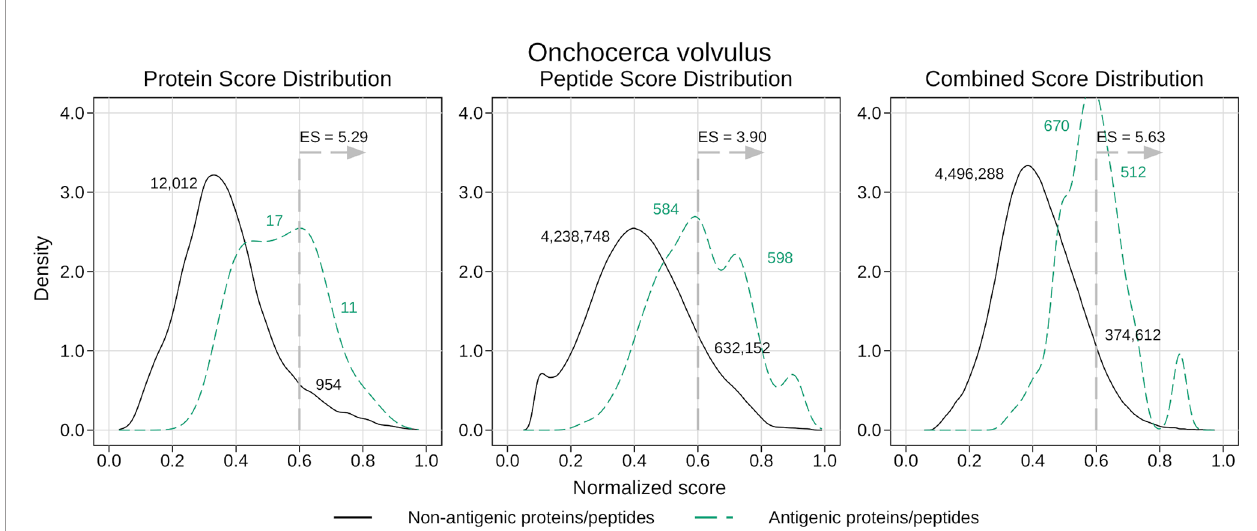
FIGURE 5 | Density analysis for the antigenicity scores of Onchocerca volvulus . Plots were obtained by analyzing the proteome of O. volvulus with the fi nal generic models, and then distinguishing between antigens and non-antigens. The fi gure shows the enrichment score obtained by keeping only the proteins and peptides with a score greater than 0.6, as well as the amount of antigens and non-antigens that would be inside or outside that subset. The plots correspond to the case where a protein was tagged as antigenic if it had at least 3 ‘ immunoreactive ’ peptides (see Results ).